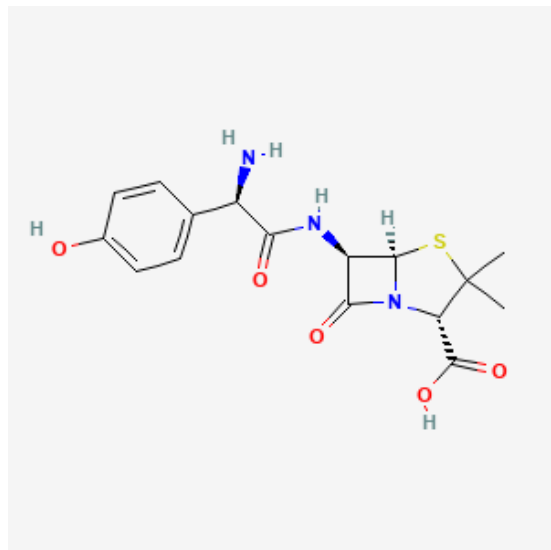
Figure 4. 2D chemical structure of amoxicillin.